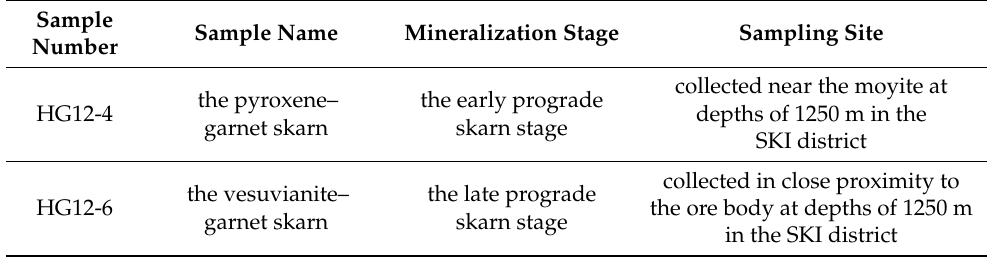
Table 1. Sampling of garnets from various mineralization stages in the Huanggang